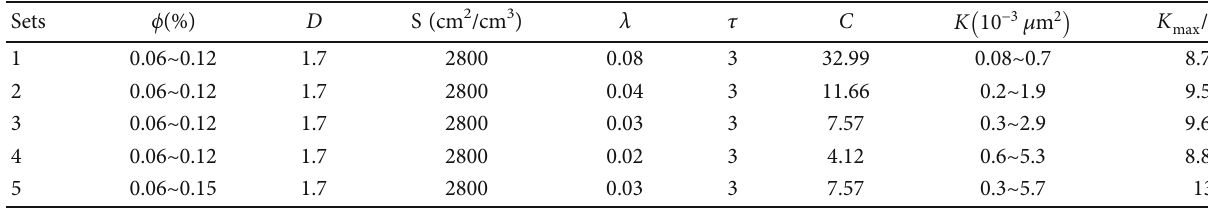
Table 2: Basic parameters of heterogeneous reservoirs.